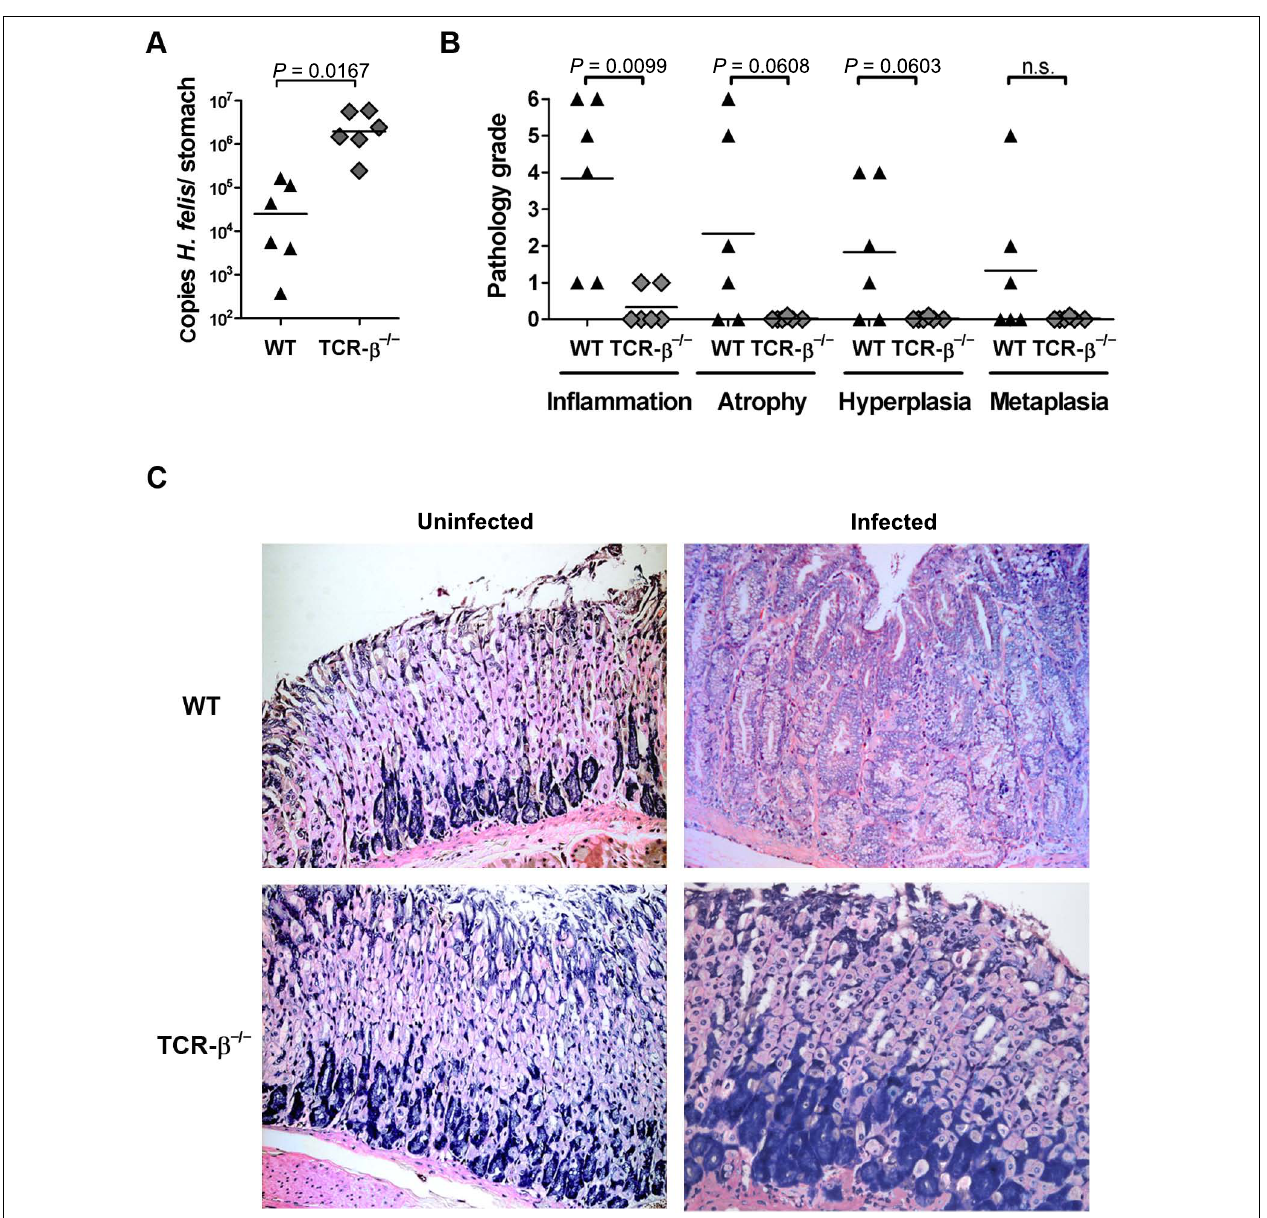
mouse. (B) Histopathology scores assigned to every mouse shown in (A) for all indicated parameters on a scale of 0–6. (C) Representative micrographs of Giemsa-stained sections of H. felis -infected and uninfected wild type and TCR- β − / − mice, respectively. Data are representative of three independent